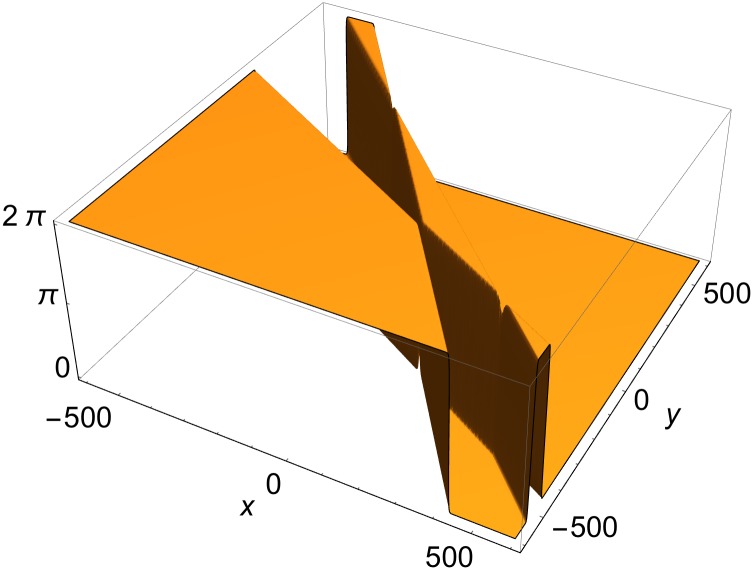
Three-front solution of Eq (1) at t = 0, z = 50.p(1) = {0, cosφ(1), sinφ(1), 0}, p(2) = {0, cosφ(2), sinφ2, 0}, p(3) = {1, cosφ(3), sinφ(3), 1}, φ(1) = π/5, φ(2) = π/4, φ(3) = π/3; δ(1) = 0, δ(2) = 50, δ(3) = −50.